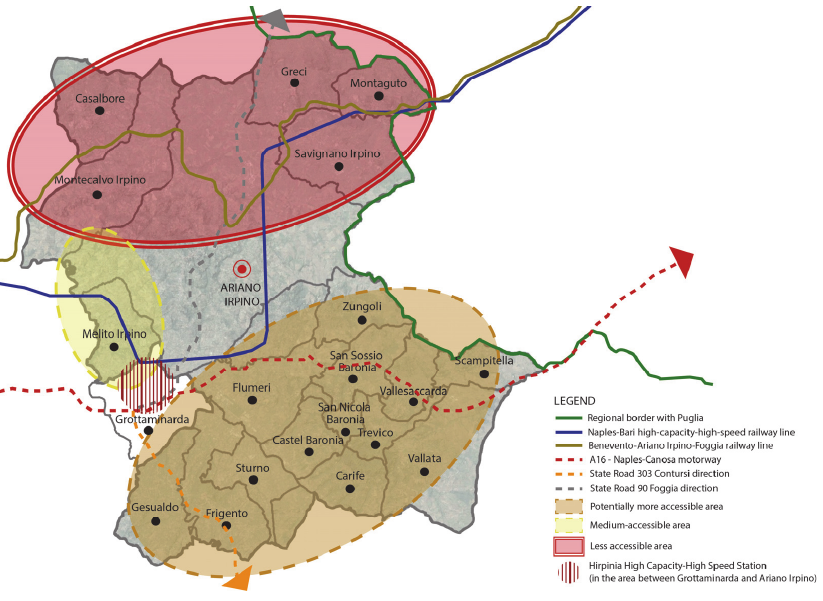
Figure 6. Interpretative map of the Ufita territory © RI.P.R.O.VA.RE Project (DICIV research unit).